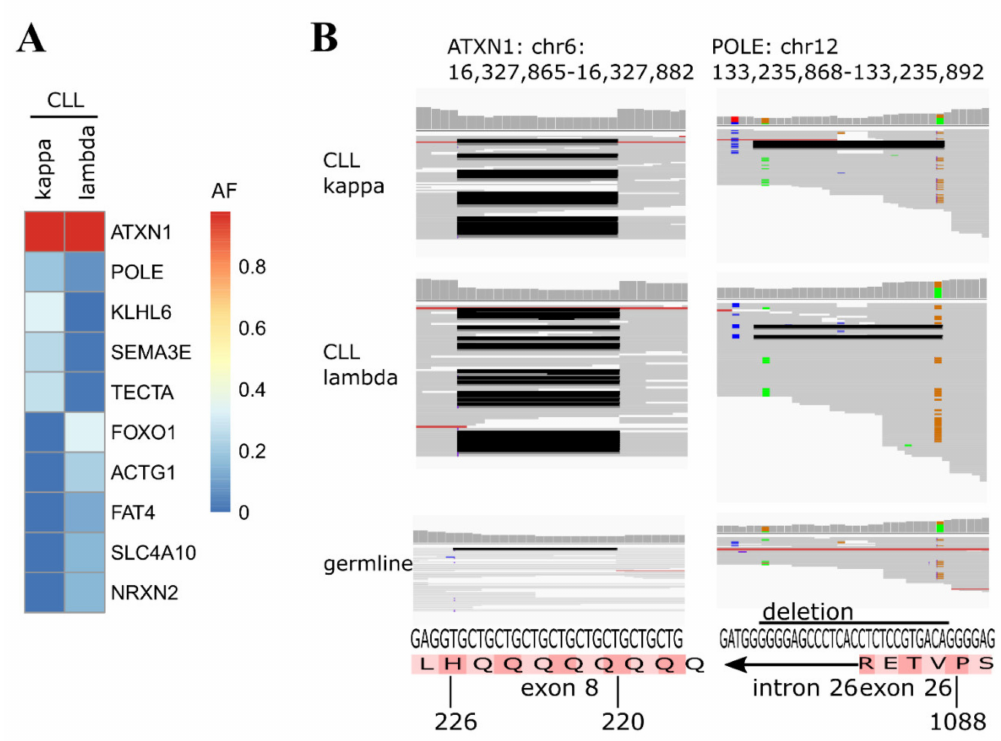
Figure 2. Focused exome sequencing of individually purified CLL kappa and lambda clones and a prostate carcinoma sample. ( A ) Allelic frequencies (AF) of all genes carrying mutations in the prostate carcinoma; the kappa and lambda clones are shown. All samples share the same mutations in the ATXN1 and POLE genes. ( B ) In-frame deletion within the ATXN1 gene and 25 nucleotide splice site within the POLE1 gene are depicted for all cancer samples and the corresponding germline control from a buccal